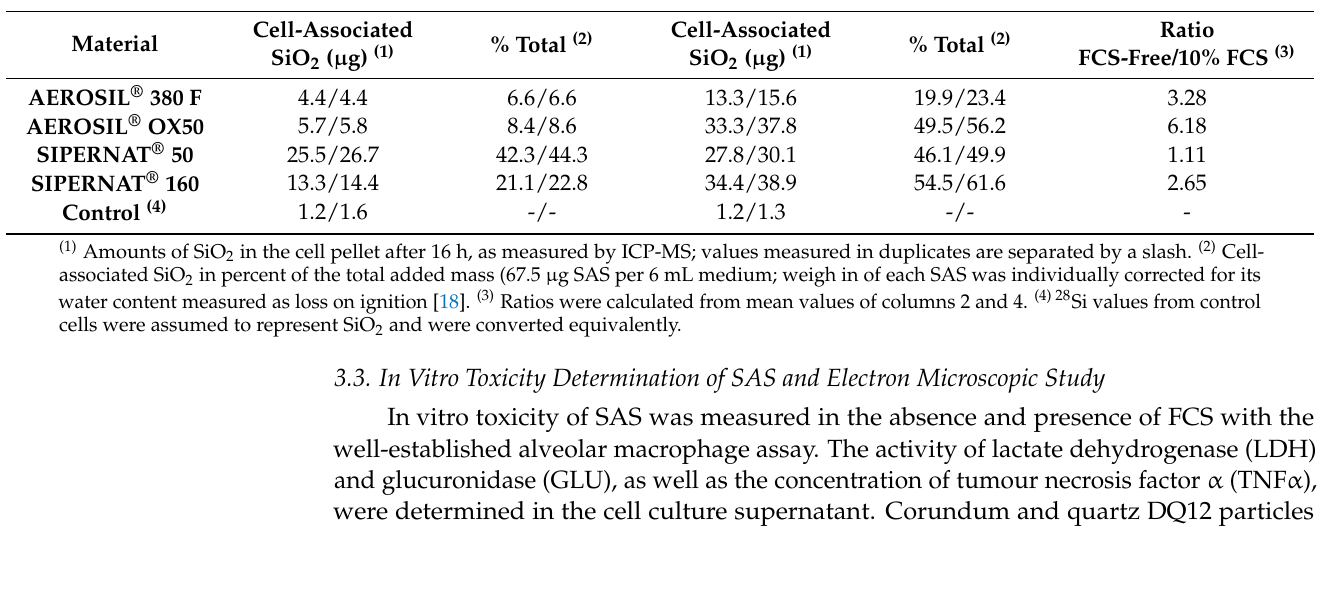
Table 2. Quantification of SiO 2 uptake in the absence and presence of foetal calf serum (FCS).